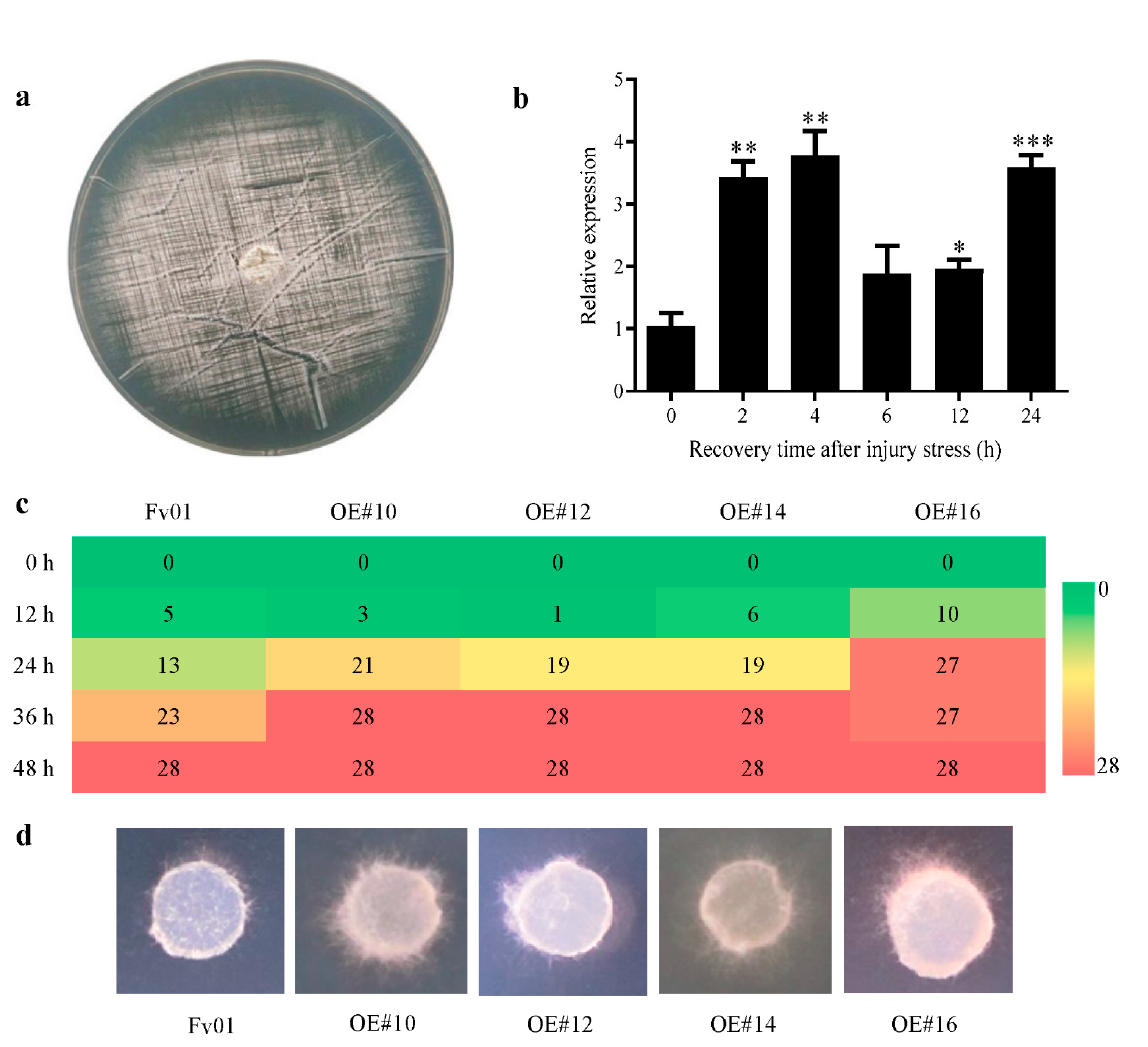
Figure 4. The expression pattern of F. filiformis FfGS6 in response to injury stress and mycelial repairability of its overexpression transformants. ( a ) F. filiformis Fv01 mycelial injury stress induction; ( b ) FfGS6 gene expression at different recovery time points (0, 2, 4, 6, 12, and 24 h) after Fv01 mycelial injury induction. Asterisks represent significant differences versus Fv01 ( t -test, n = 3; *, p < 0.05; **, p < 0.01; ***, p < 0.001). ( c ) Recovery ability assessment within 48 h after mycelial injury. ( d ) The repair of mycelium after 48 h of injury stress induction.